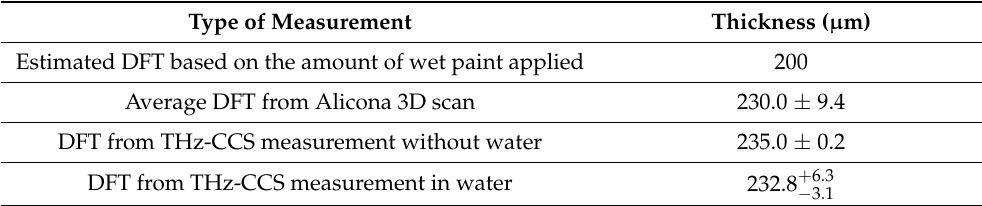
Table 1. The Alicona 3D thickness denotes the average and standard deviation of DFTs from the cross-sectional point measurements. The THz-CCS measurements were single-point measurements with 68% confidence